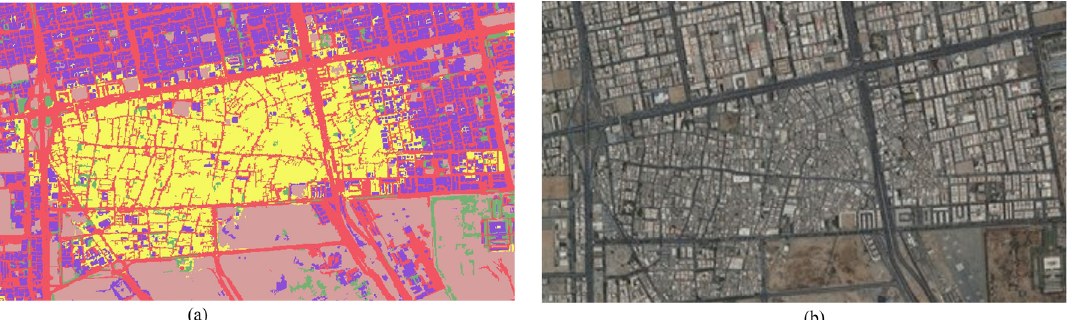
Figure 12. The impact of dwelling size and other indicators on informal settlement mapping. ( a ) Shows the informal settlement (Bin Malek district) in yellow, ( b ) shows the used GeoEy1-1 satellite imagery in random forest classification.